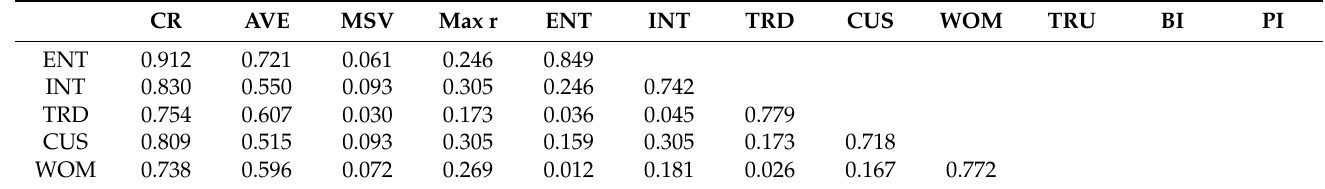
Table 2. Tests of discriminant validity, convergent validity, and composite